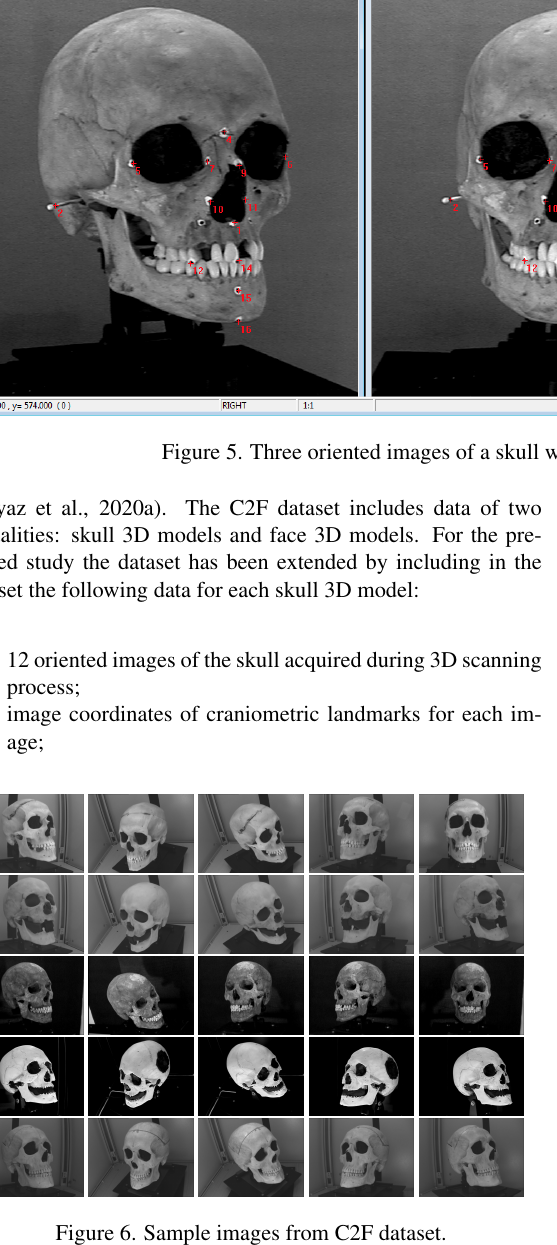
Figure 6. Sample images from C2F